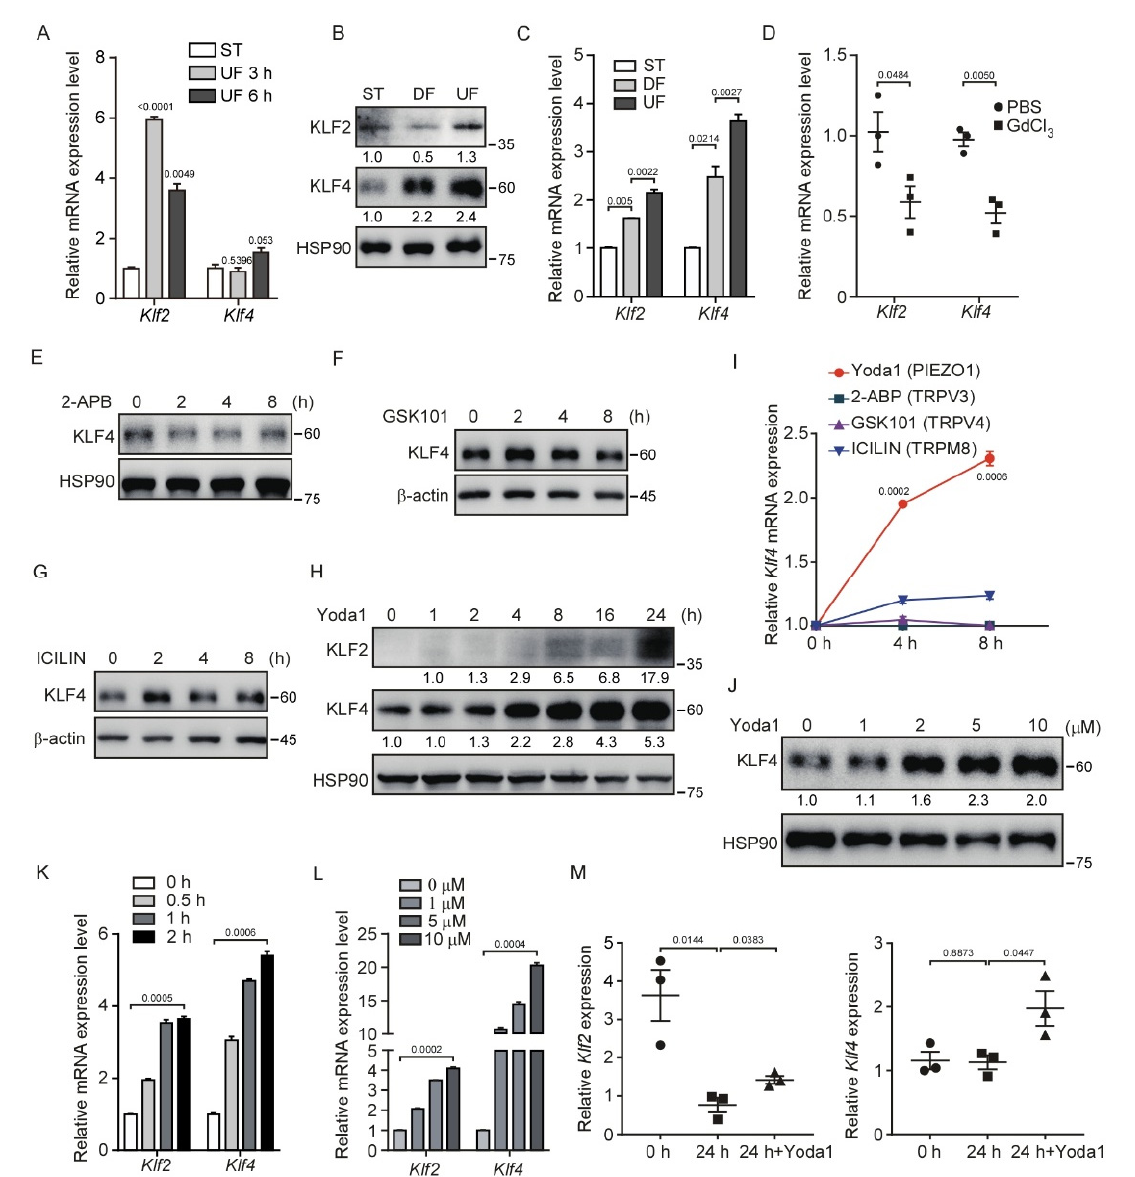
Figure 1. Shear stress induces KLF2/4 expression through PIEZO1 activation. ( A ) MBMECs were seeded in a flow chamber and exposed to unidirectional laminar flow with 16 dyn/cm 2 for indicated time, and mRNA levels of Klf2 and Klf4 were measured by quantitative RT-PCR. ( B , C ) MBMECs were exposed to differential shear stress for 5 days. KLF2 and KLF4 proteins were monitored by western blotting ( B ), and mRNA levels of Klf2 and Klf4 were measured by quantitative RT-PCR ( C ). ( D ) Wild-type male ICR mice were injected with GdCl 3 (20 mg/kg) via tail vein every 12 h for 4 times, and thoracic aortas were collected for quantitative RT-PCR. ( E – H ) MBMECs were treated with indicated mechanosensitive ion channel agonists including 2 − APB (TRPV1/2/3 agonist, 100 µ M), GSK1016790A (TRPV4 agonist, 10 µ M), ICILIN (TRPM8 agonist, 10 µ M) and Yoda1 (PIEZO1 agonist, 5 µ M) for the indicated time. Protein ( E – H ) levels of KLF4 were monitored by western blotting, respectively, and quantified with ImageJ ( I ). ( J ) MBMECs were treated with Yoda1 with the indicated concentration for 8 h, and KLF4 proteins were monitored by western blotting. ( K ) MBMECs were treated with Yoda1 (5 µ M) for the indicated time, and mRNA levels of Klf2 and Klf4 were measured by quantitative RT-PCR. ( L ) MBMECs were treated with Yoda1 with the indicated concentration for 2 h, and mRNA levels of Klf2 and Klf4 were measured by quantitative RT-PCR. ( M ) The thoracic aortas